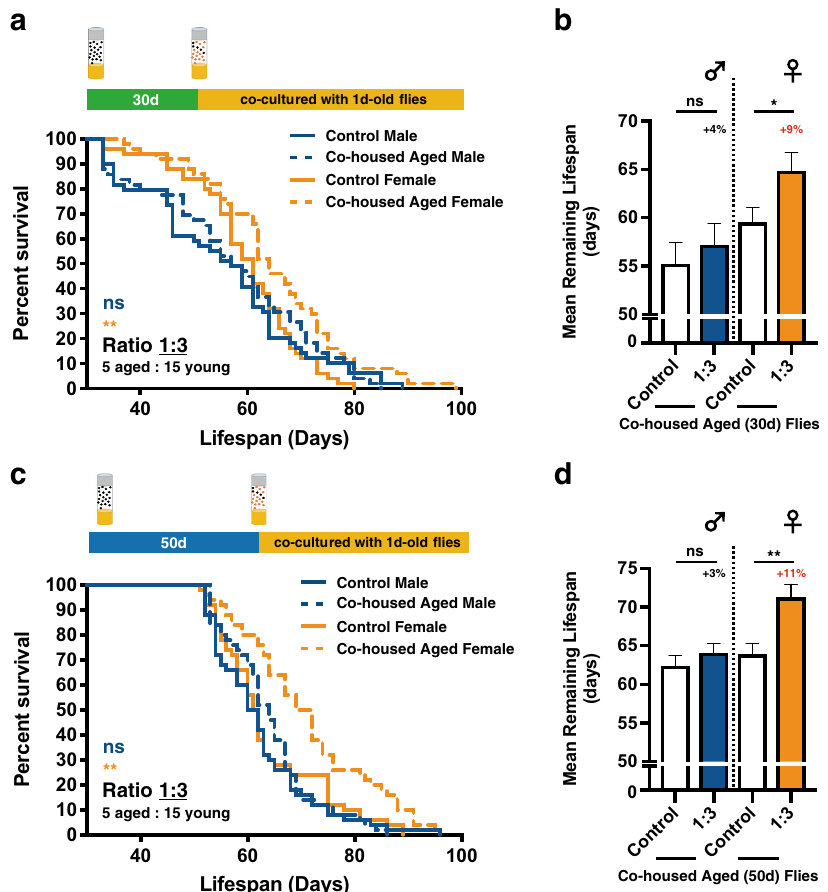
Fig. 2 Lifespan extension phenotypes are affected by the chronological age of aged fl ies. Canton-S fl ies of indicated chronological ages (30d- and 50d-old) were co-housed with 1d-old fl ies at the cohort ratio of 1:3. Results were expressed as ( a , c ) survival curves and ( b , d ) means ± SEM. In all cases, the longevity-promoting effects were more robust in female fl ies. P values: ns > 0.1234; <0.0332*; <0.0021**. P values of the columns were annotated by the Mann – Whitney test and survival curves were annotated by the Log-rank (Mantel-Cox) test. Sample size: n = 49~50 for each column; results were collected from 10 independent experimental